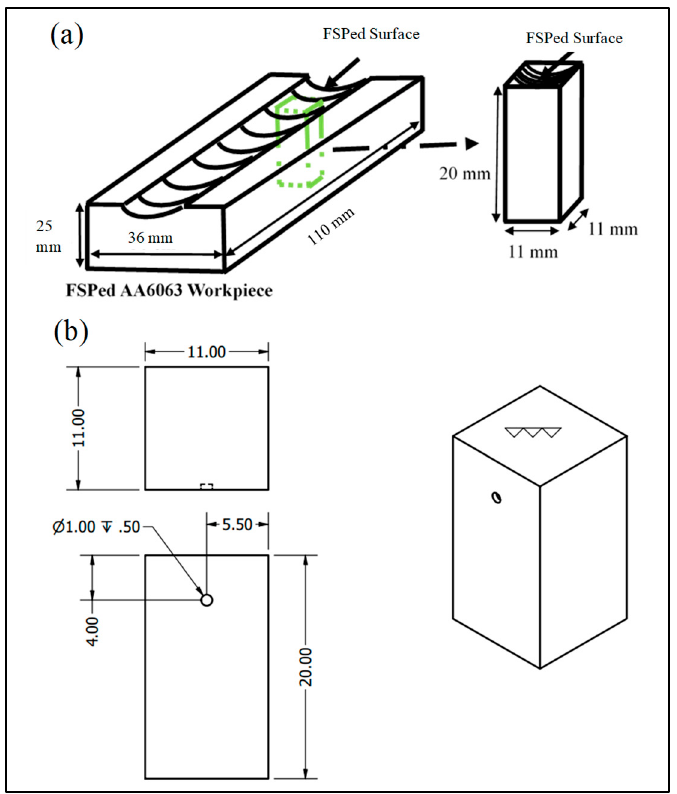
Figure 4. Tribo-test sample, ( a ) cut from FSPed workpiece, and ( b ) CAD drawing.